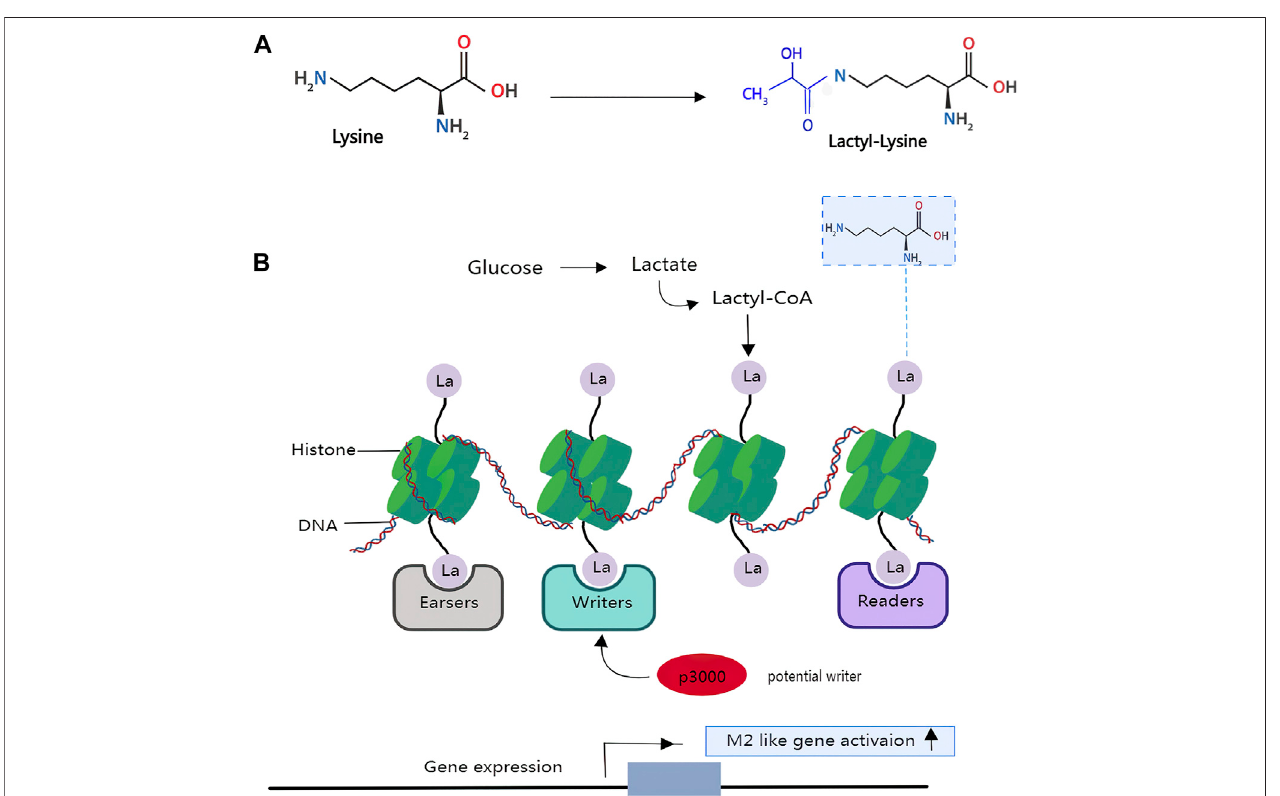
FIGURE 3 | Lactate modi fi es histones to regulate macrophage polarization and tumour immunity: An achemical modi fi cation called lactylation — the addition of a lactyl(La)grouptothelysineamino-acidresiduesinthetailsofhistoneproteins. (A) ,thestructureoflysineandlactylgroup. (B) ,glucosecanbeincompletelyconvertedto the metabolite lactate in the macrophages or under a hypoxia situation. The lactyl-CoA generated from lactate contributes a lactyl group to the lysine tails of histone proteins via the acetyltransferase enzyme p300 to produce the epigenetic modi fi cation called lactyllysine, which allows for gene activation of genes belonging to wound-healing pathways,thus resultinginan M2-likephenotype. However, itisunclear whichenzymesgenerate theintermediatemolecule lactyl-CoA,fromwhichLais derived, or which enzymes deposit (writers), remove (erasers) or recognize and interpret (readers) histone lactylation.